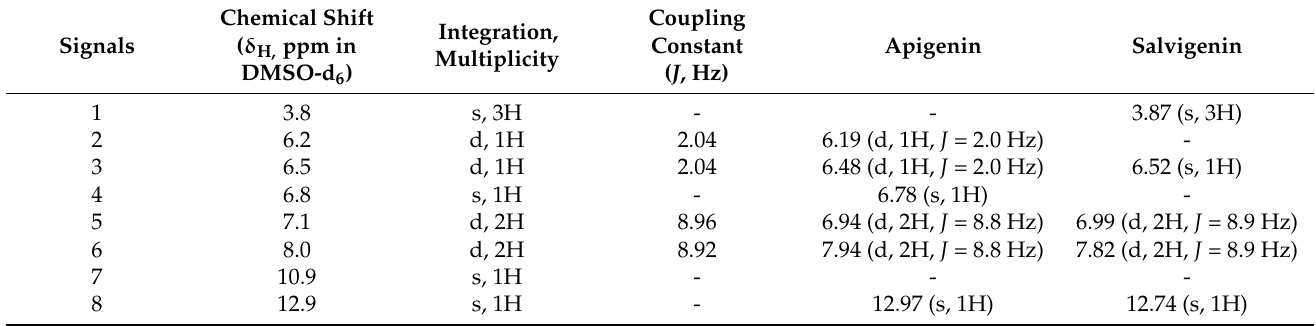
Table 6. 1 H-NMR spectral data of compound A isolated from the C. erythrophyllum leaf acetone extract.